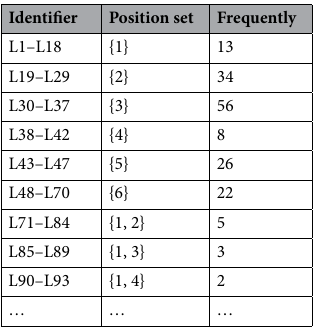
Table 3. Location transaction